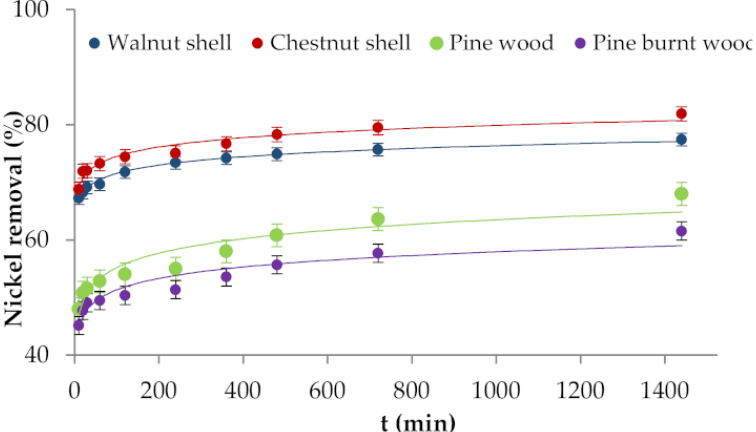
Figure 10. Adsorption efficiency versus time, from 10 to 1440 min by the different adsorbent materials using 25 mg L − 1 nickel solutions and 100 mg of adsorbent.